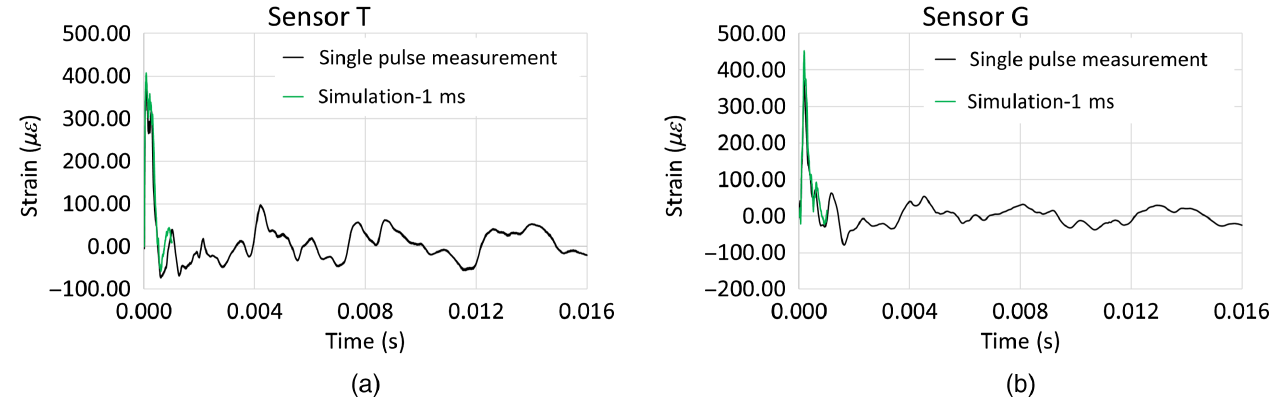
FIG. 26. Strain response from example pulses at locations T (a) and G (b) for 16